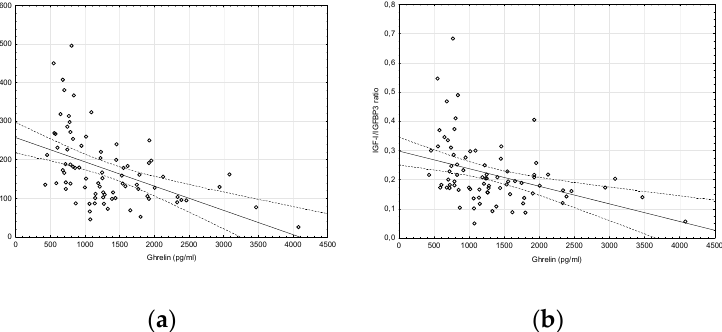
Figure 3. Correlation between: ( a ) ghrelin and IGF ‐ I concentrations (r = − 0.47, p < 0.05); ( b ) ghrelin concentration and IGF ‐ I/IGFBP ‐ 3 molar ratio (r = − 0.27, p < 0.05).